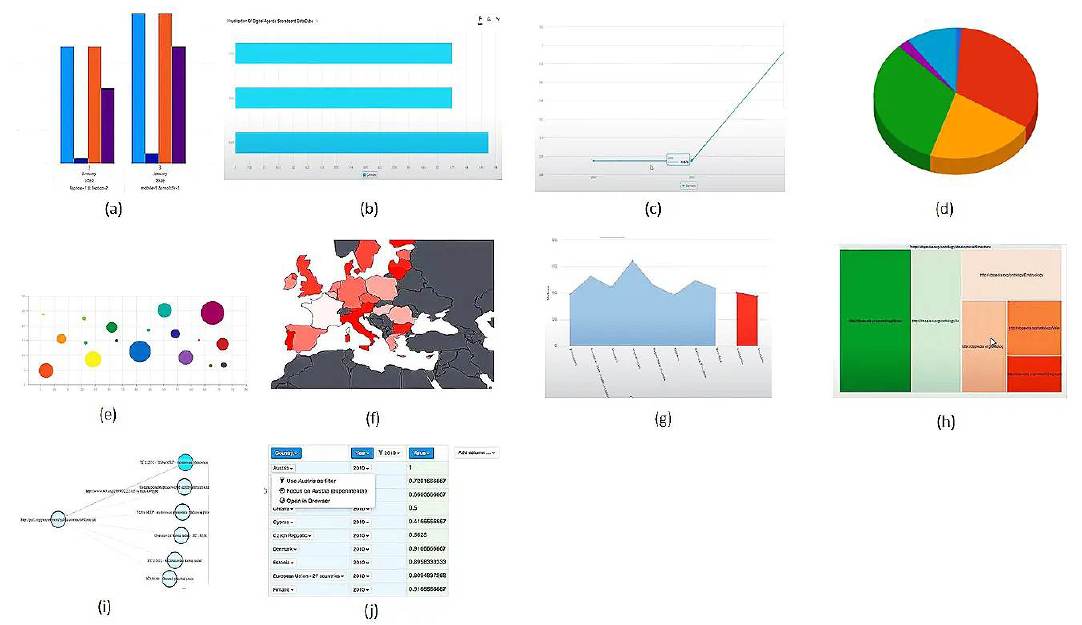
Figure 8. Indicative Screenshots of Visualization of analytical results for Categories C1-C2: ( a ) column chart (C1, C2), ( b ) bar chart (C2), ( c ) line chart (C2), ( d ) pie chart (C2), ( e ) bubble chart (C2), ( f ) geo chart (C2), ( g ) area (C2), ( h ) treemap (C1, C2), ( i ) graph (C2), ( j ) table (C2).